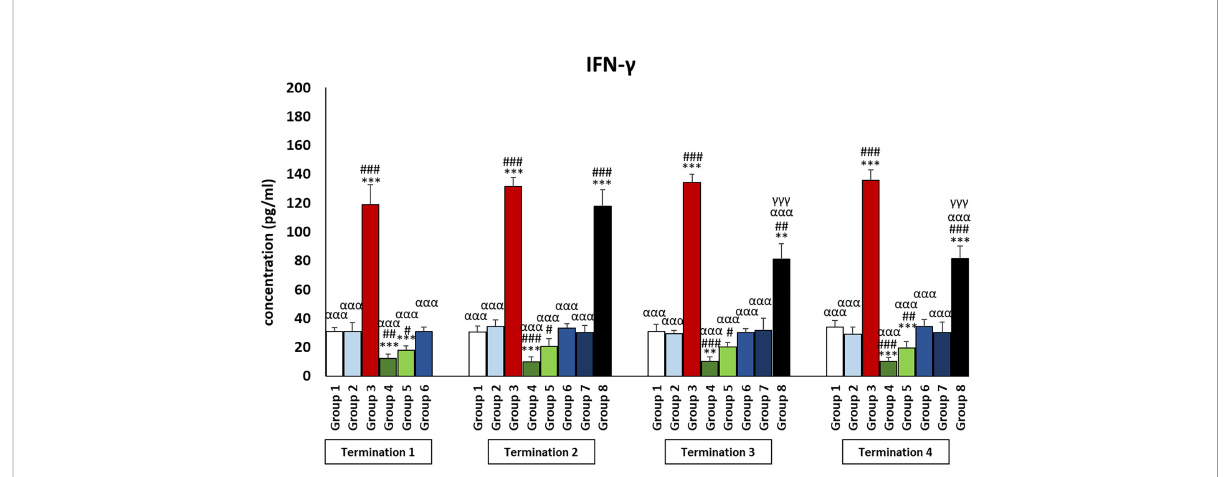
FIGURE 2 Changes in the levels of IFN- g in the blood of chickens receiving phage therapy or antibiotic therapy after 6, 20, 28, and 34 days of experiments. Results are presented as mean values ± SD. Statistical analyses were performed by Kruskal – Wallis test and post-hoc Dunn test or ANOVA and post-hoc Tukey ’ s test. The signi fi cance of differences between controls and particular treated groups is observed and marked by the following: asterisks (*) vs. saline control; (#) vs. phage control (group 2); (a) vs. infected control (group 3); (g) vs. termination 2. p < 0.001 (***, ###, aaa , ggg ), p < 0.01 (**, ##), and p < 0.05 (*,